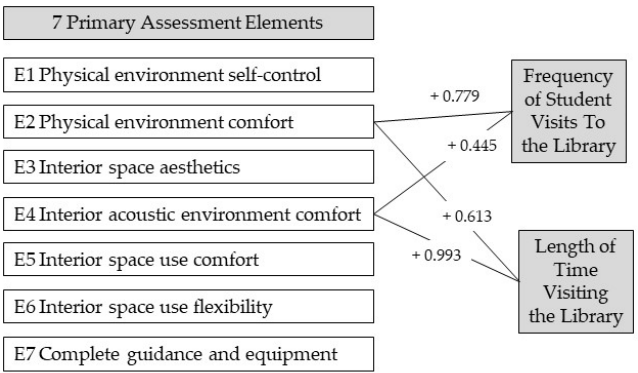
Figure 6. Empirical research conclusion.